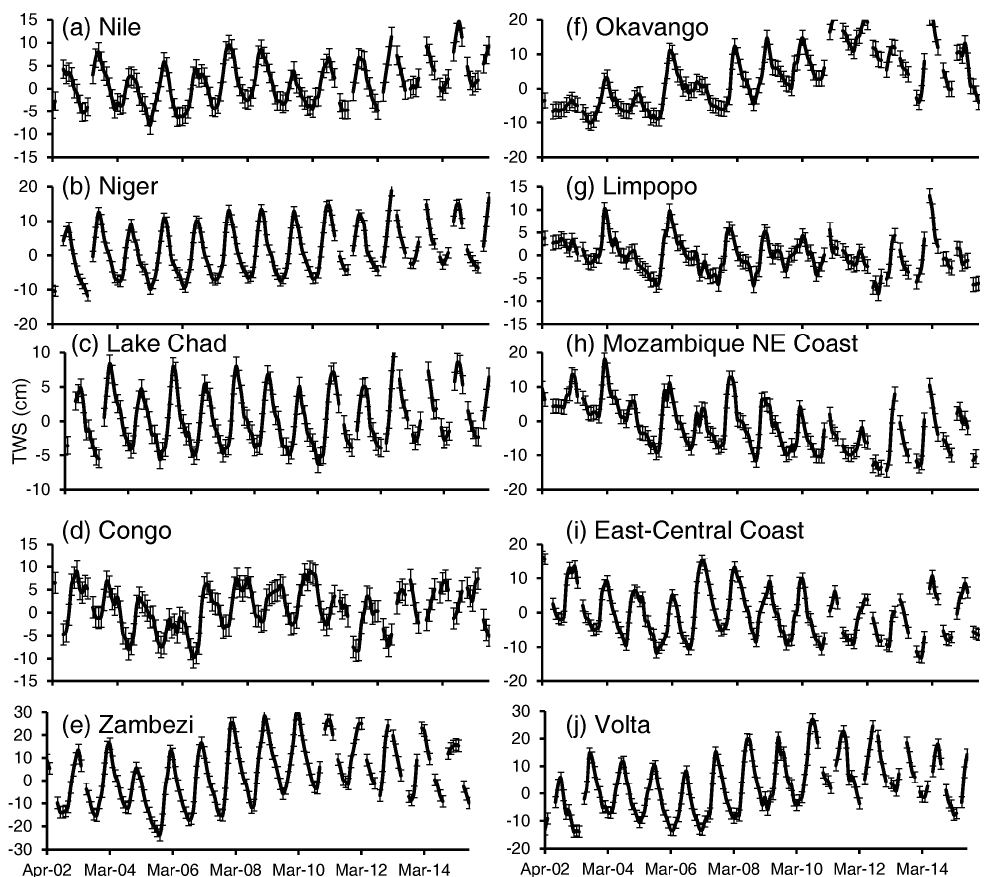
Figure 2. Temporal variations in terrestrial water storage (TWS) GRACE (in cm) during the period from April 2002 to September 2015 averaged over 10 African watersheds. April 2002 to September 2015 averaged over 10 African